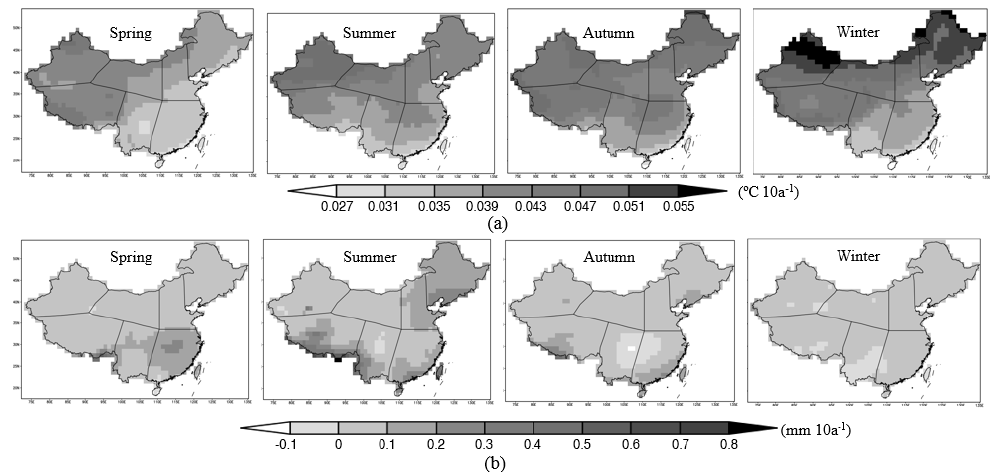
Figure 4. Geographic distribution of projected changes in the mean monthly temperature (a) and precipitation (b) using the multimodel ensemble mean from 1950 to